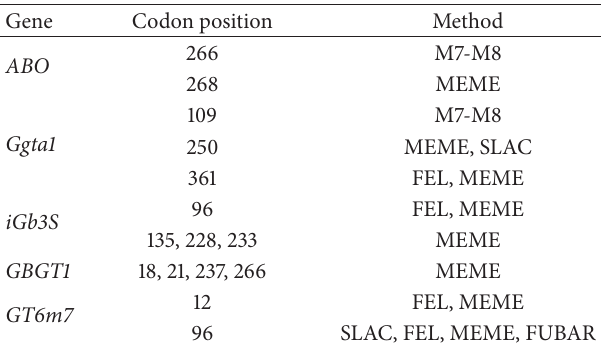
Table 1: Codons under positive selection or diversifying selection with values significant obtained by Codeml or HyPhy